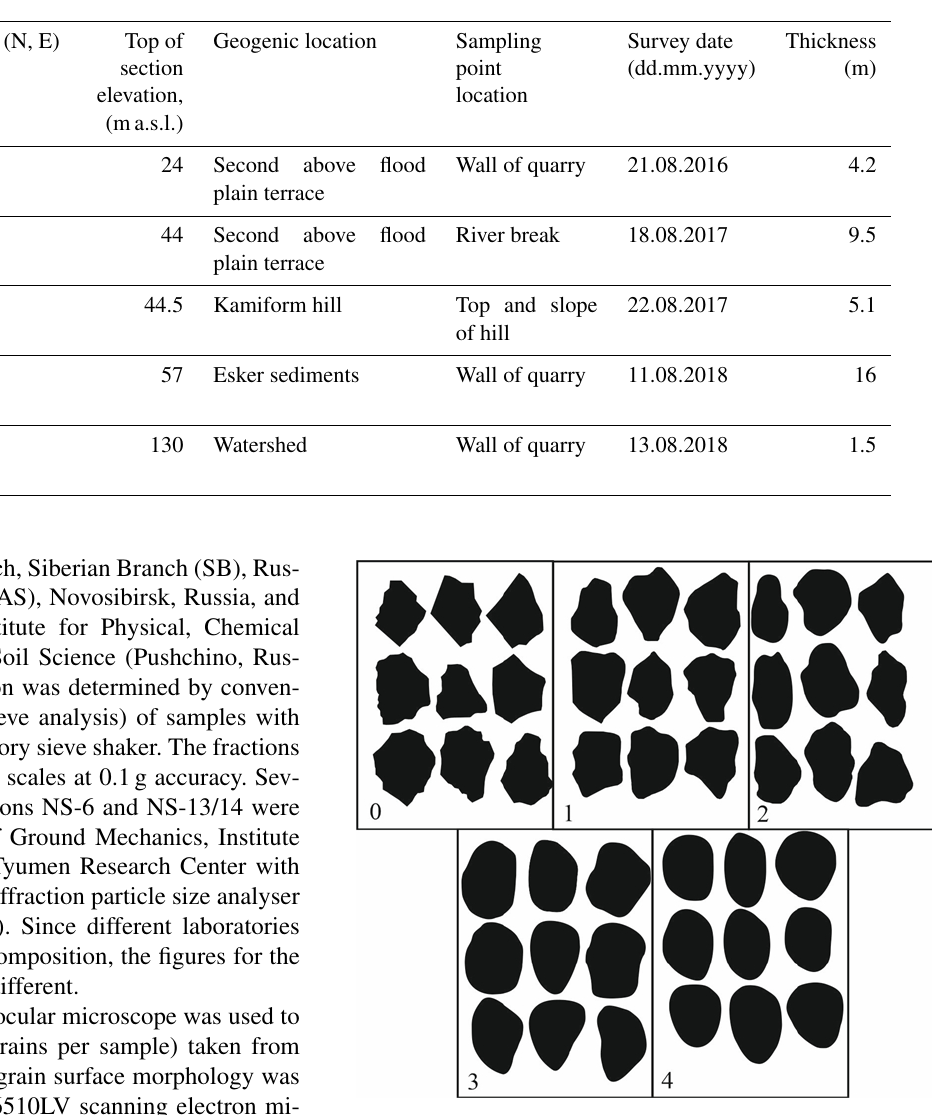
Table 1. Site properties.